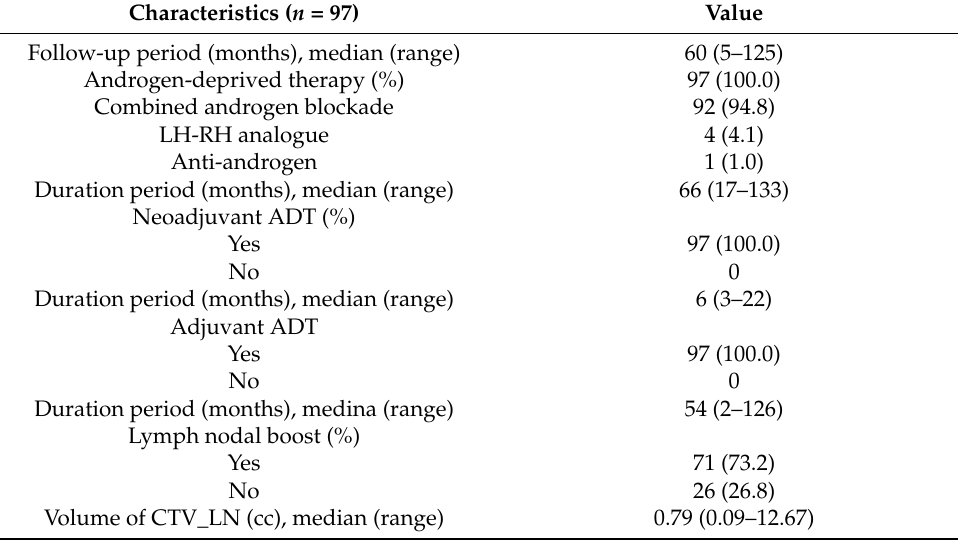
Table 2. Treatment